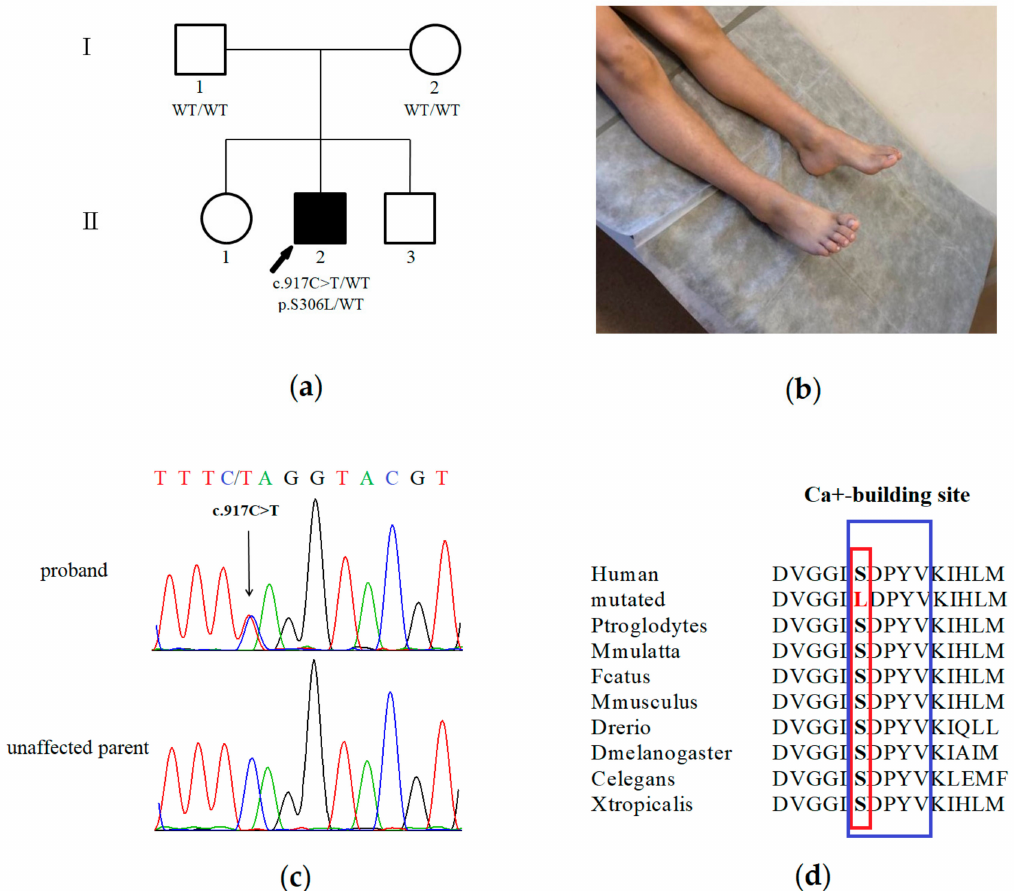
Figure 1. Clinical presentation and genetic testing of the proband with a variant in the SYT2 gene: ( a ) The family tree showing the a ff ected proband and una ff ected parents and siblings; ( b ) Proband showing foot deformity and lower limb wasting; ( c ) Sanger sequencing results demonstrating the heterozygous c.917C > T missense SYT2 mutation in the proband; ( d ) Position of the c.917C > T mutation (red) in the SYT2 protein structure. This variant was highly conserved throughout di ff erent species. The cytoplasmic C2B domain of SYT2 is highlighted in